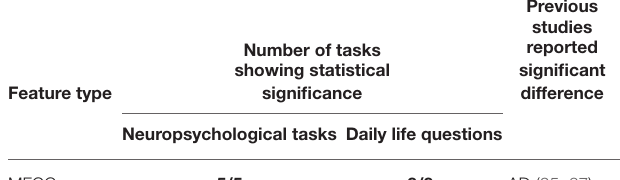
TABLE 2 | Number of questions showing statistical significance for each feature type between CN and MCI participants, and previous studies that reported significant differences in each feature type extracted from speech data during neuropsychological